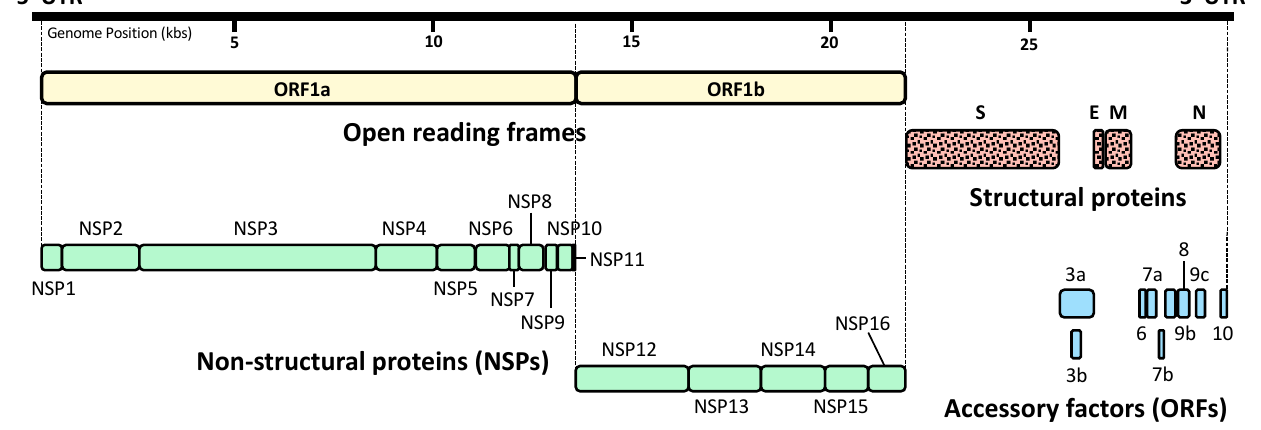
Figure 2. SARS-CoV-2-encoding proteins expressed from its RNA genome. SARS-CoV-2 expresses a total of 29 proteins from its positive-sense single-stranded RNA genome. Open reading frame 1a (ORF1a) and ORF1b are expressed after digestion by the viral protease 16 non-structural proteins (NSPs) in which ORF1a and ORF1b respectively encode 11 proteins (NSP1 to NSP11), and five proteins (NSP12 to NSP16). SARS-CoV-2 also expresses four structural proteins, spike (S), envelop (E), membrane (M), and nucleocapsid (N) proteins, as well as nine accessory factors, ORF3a, 3b, 6, 7a, 7b, 8, 9b, 9c and 10, from their own ORFs. NSP: non-structural protein, ORF: open reading frame, UTR: untranslated region.